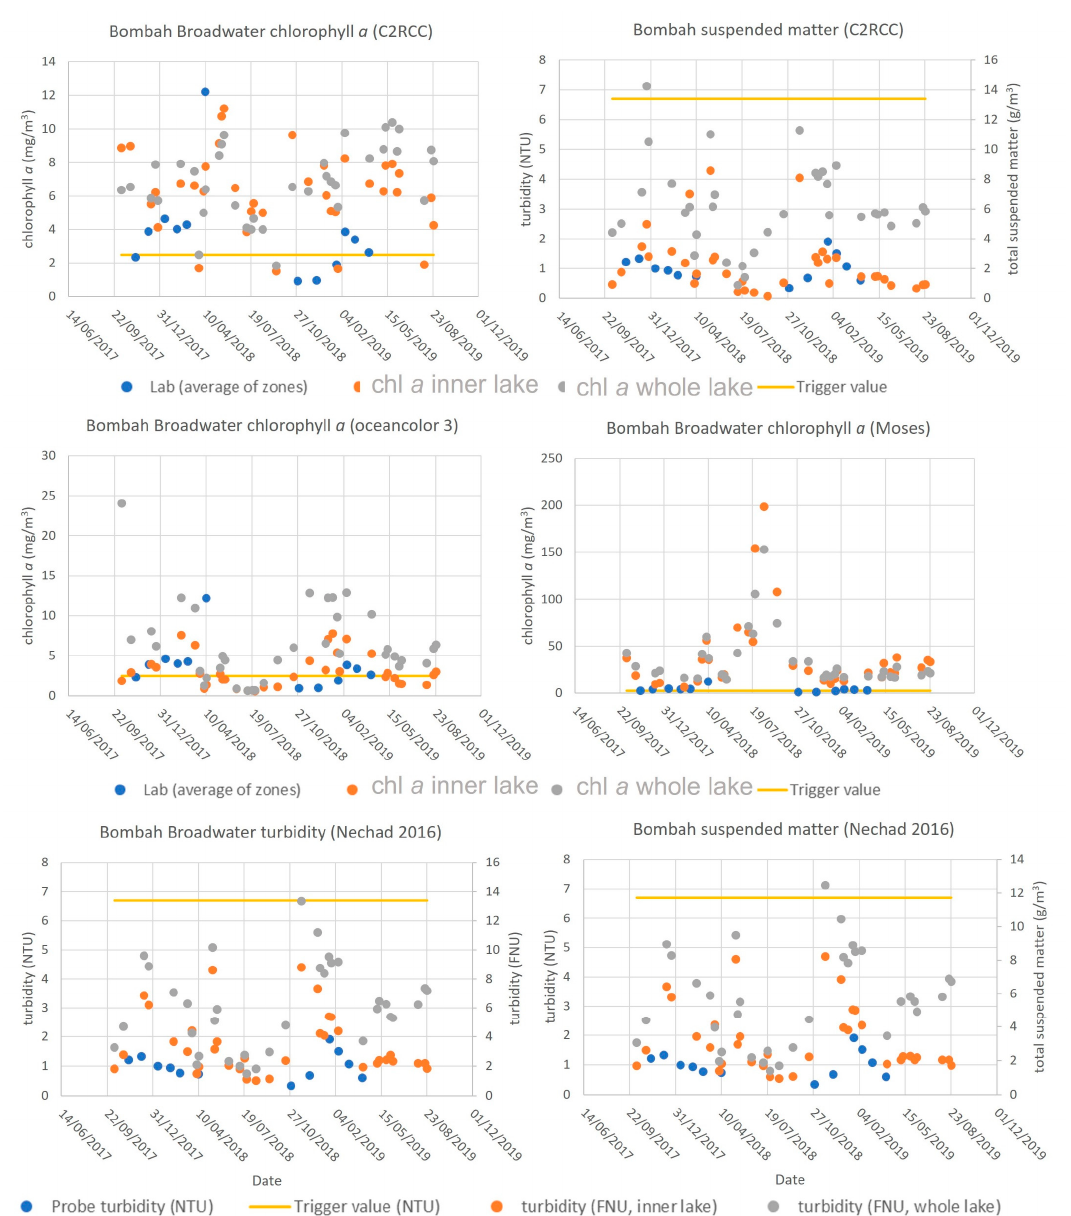
Figure 4. Chlorophyll a in situ measurements from lab analyzed water samples and RS product estimates for Bombah Broadwater between September 2017 and August 2019. Water clarity is shown in FNU, Nechad 2016), and total suspended ma tt er (g/m 3 ), Nechad 2016 and, C2RCC). Chlorophyll a concentrations (mg/m 3 ) are shown for C2RRC, Moses and oceancolor.